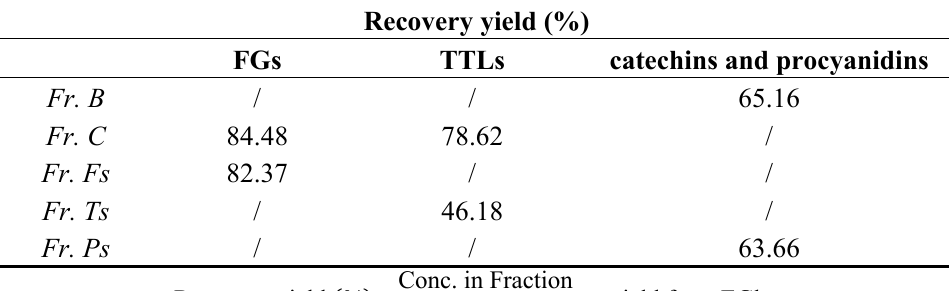
Table 6. Recovery yield of each fraction from EGb.